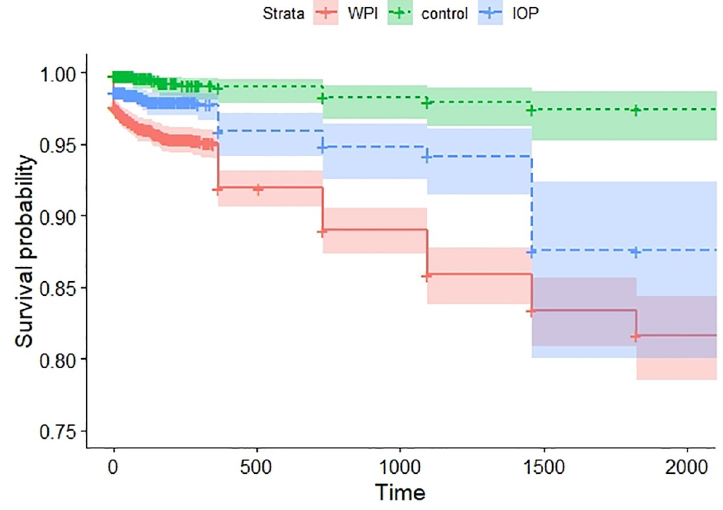
Fig 1. Survival probability (event = death) in the WPI, IOP and random control